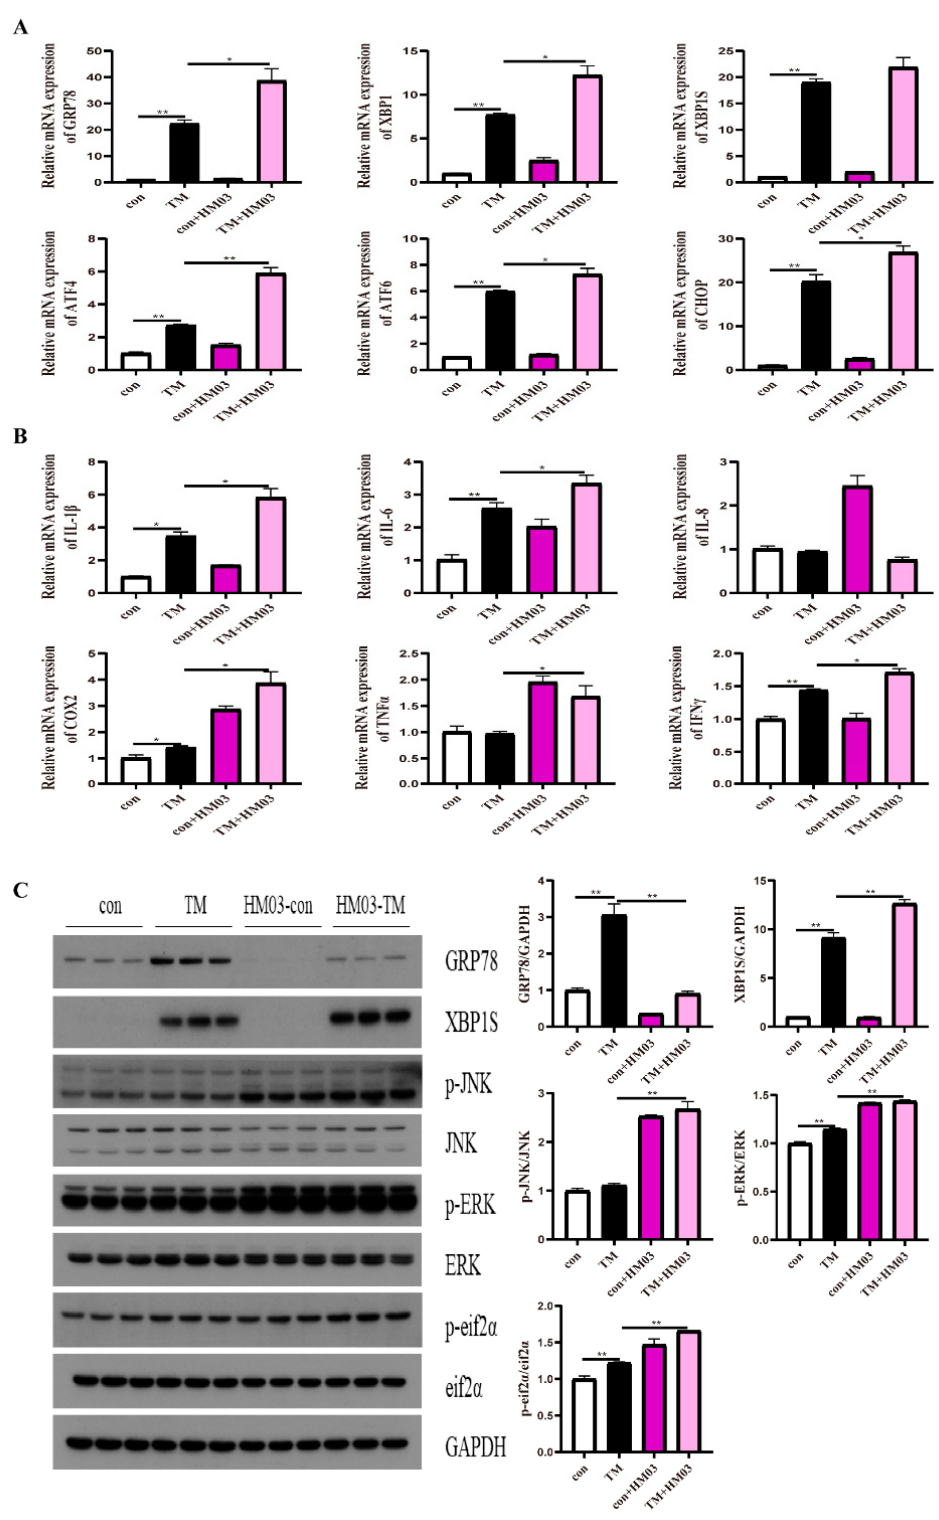
Figure 6. Effects of 10 µ M HM03 treatment for 4 h before 1 µ M TM incubation for 16 h on ER stress and inflammation in macrophages of large yellow croakers. ( A ) Relative mRNA expression of ER stress-related genes. ( B ) Relative mRNA expression of inflammatory genes. ( C ) Protein levels of ER stress-related proteins and inflammatory-related proteins. Values are presented as mean ± SEM ( n = 3). * Significant difference ( p < 0.05); ** highly significant difference ( p < 0.01).